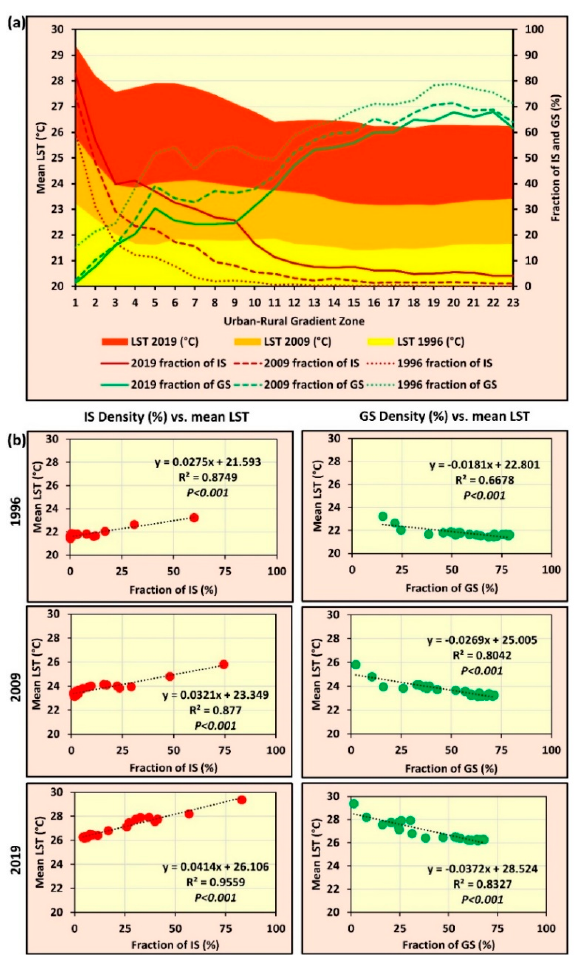
Figure 5. ( a ) The spatial pattern of mean LST, and the faction of IS (FIS) and the fraction of GS (FGS); ( b ) results of linear regression analysis along URGZ, 1996, 2009 and 2019.